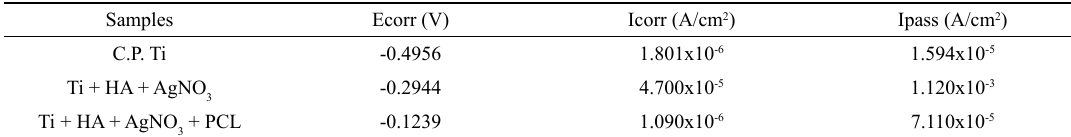
Table 1. Electrochemical parameters obtained in 1.5 SBF at 36.5 and pH 7.4. Samples